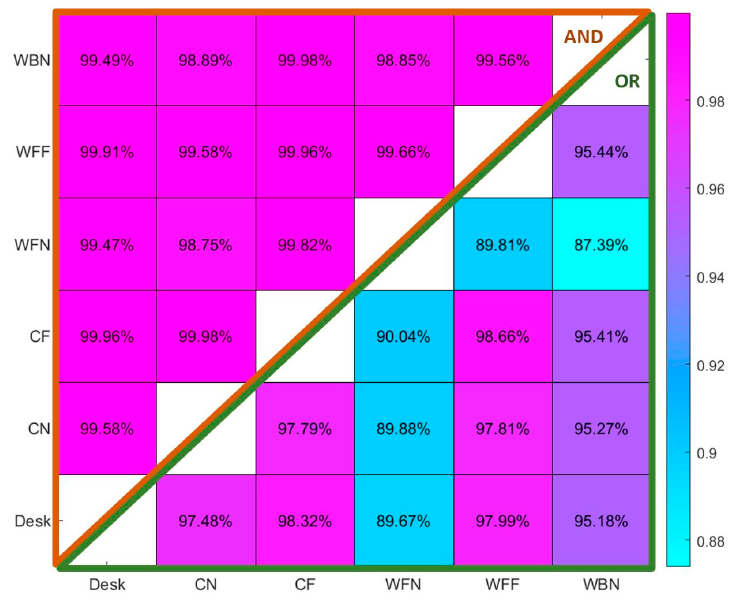
Figure 6. Accuracy of absence detection by pairwise fusion of PIR sensors.